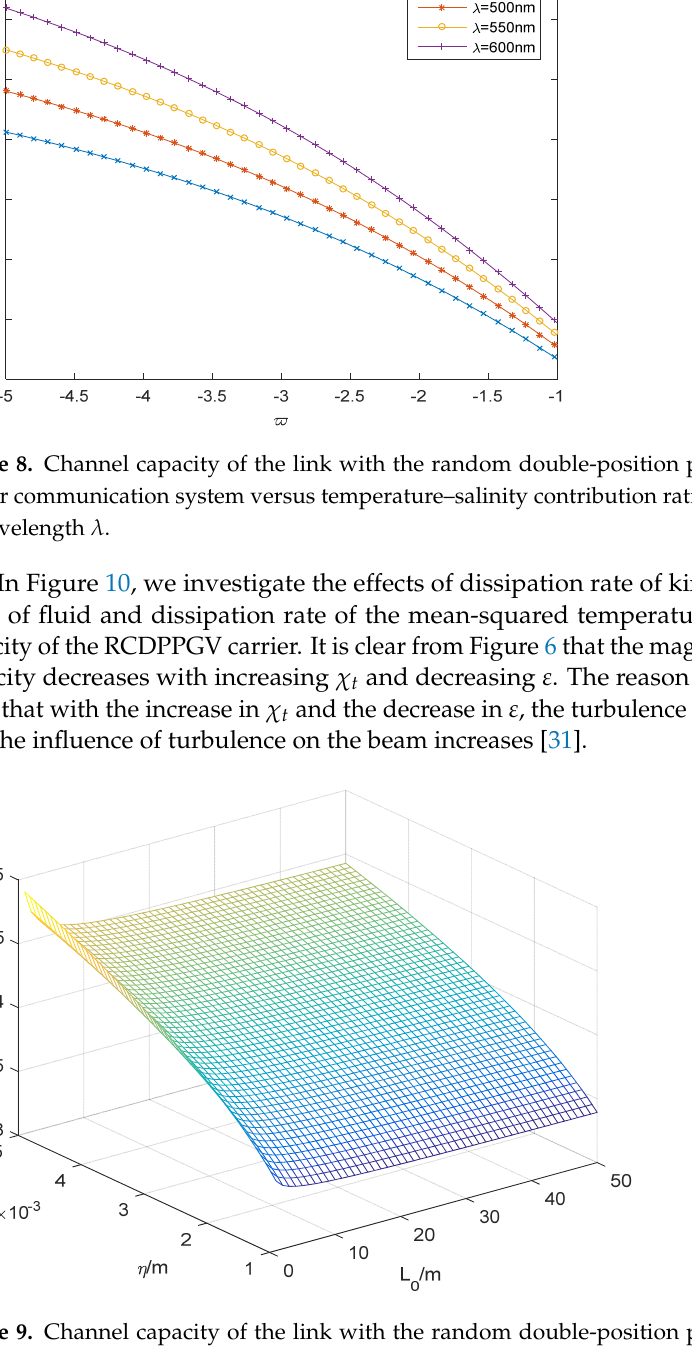
Figure 10. Channel capacity of the link with the random double − position power Gaussian vortex carrier optics communication system versus dissipation rate of kinetic energy per unit mass of fluid ε and dissipation rate of the mean-squared temperature T χ .